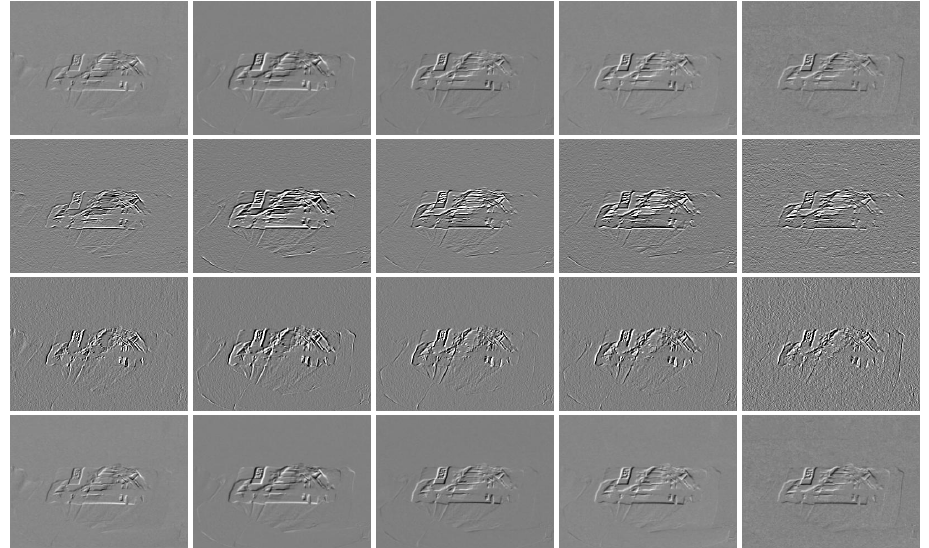
Figure 5. Magnified Hermite motion coefficients for several frames. Hermite motion components L 00 (first row). Hermite motion L 01 and L 10 (second and third rows). Hermite motion component L 11 (fourth row).